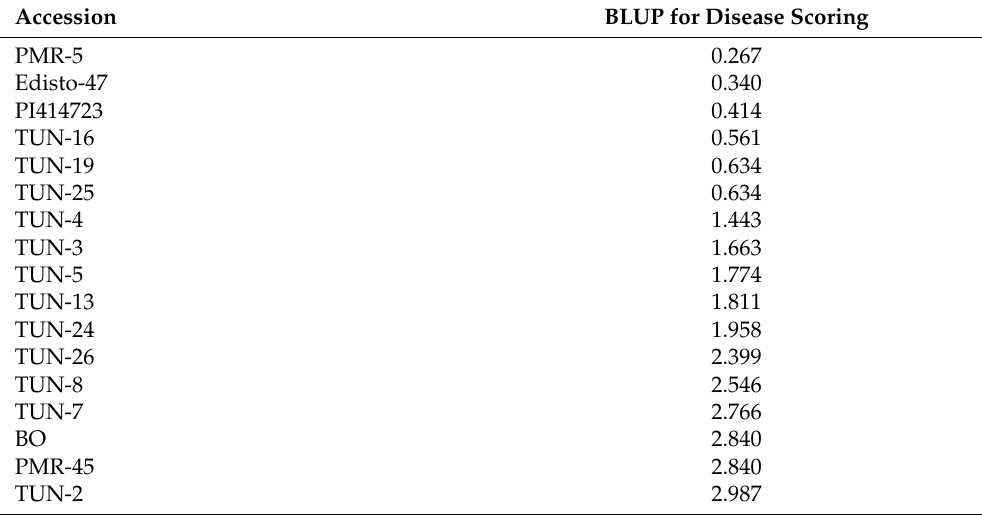
Table 4. Estimated BLUPs of the accessions regarding their response to P. xanthii Race 2. All other investigated effects (block, method, method:accession, residuals) are separated from these effects, leading to pure genetic estimations for resistance to Race